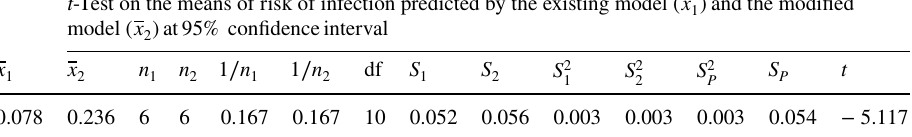
ẍ 2 = mean risk of infection predicted by modified t = cal